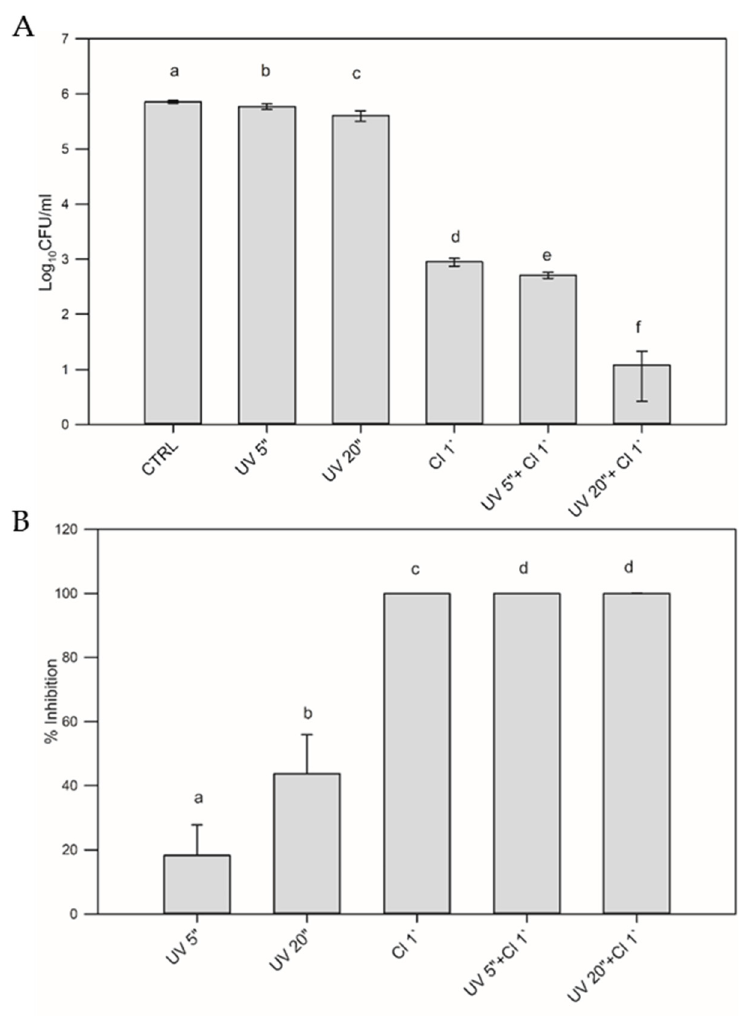
Figure 1. Effect of biofilm creation after pre-treatment of planktonic bacteria with UV 5 s (UV5”), UV 20 s (UV 20”), Cl for 1 min (Cl 1’), combination of UV 5 s and Cl for 1 min (UV5” + Cl 1’), and UV for 20 s and Cl for 1 min (UV20” + Cl 1’) and afterward incubation for 5 days (log 10 CFU/mL) ( A ). (The control is a biofilm created from untreated planktonic bacteria. The mean values are shown along with the standard deviations. ( B )) % of inhibition of biofilm formation after the above treat- ments. Lowercase letters above the results indicate the statistical significance. Different letters indi- cate statistically significant differences tested by Students t -test and Mann–Whitney U test for UV 20” + Cl 1’.